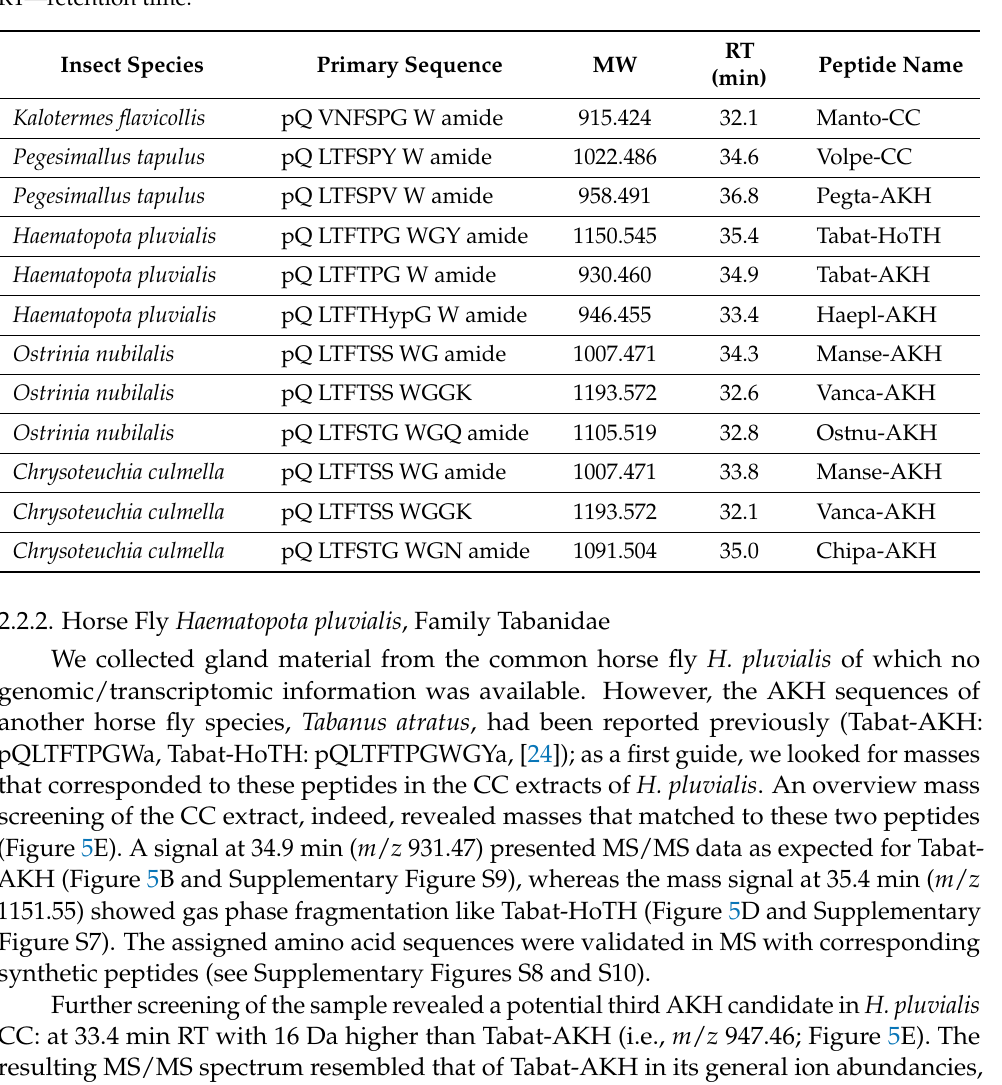
Table 1. AKHs determined in this study using high-resolution MS. MW—molecular weight, RT—retention